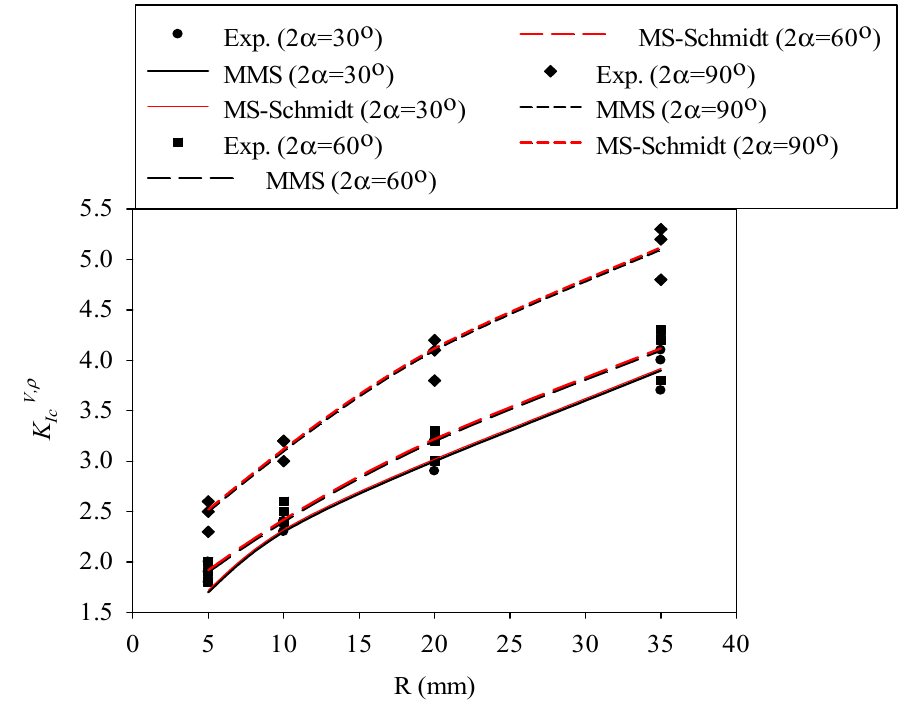
Figure 7. Variation in K IcV, ρ with specimen size for RVNBD specimens made of PMMA. Predictions provided by the MS–Schmidt and the MMS criteria, and experimental data.